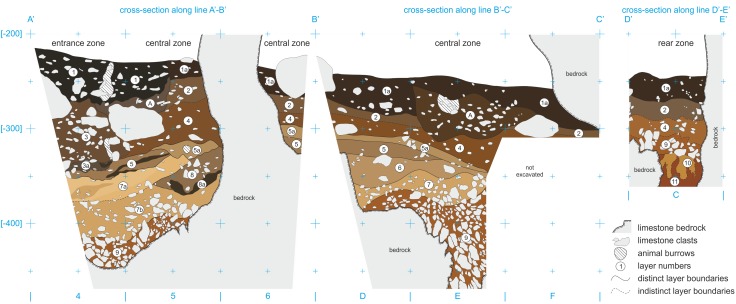
The representative geological cross-sections through the sediments of ShSIII.Natural colors of moist sediments are shown (Munsell colors are provided in text). Vertical scale is in centimeters below the site datum, which is at the elevation of around 447 m a.s.l. Location of cross-sections is shown in Fig 3.